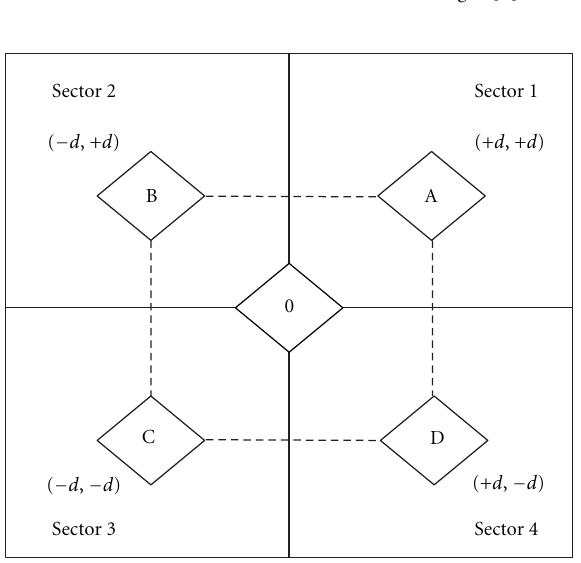
Figure 5: MPDS search in five regions of the search